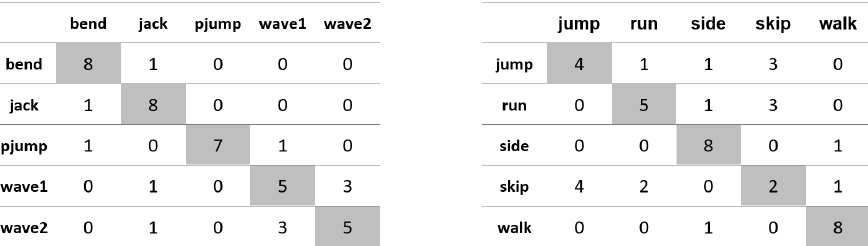
Figure A21. Confusion matrices for the experiment using the ‘upper-occlusion’ database, eccentricity and Euclidean distance.